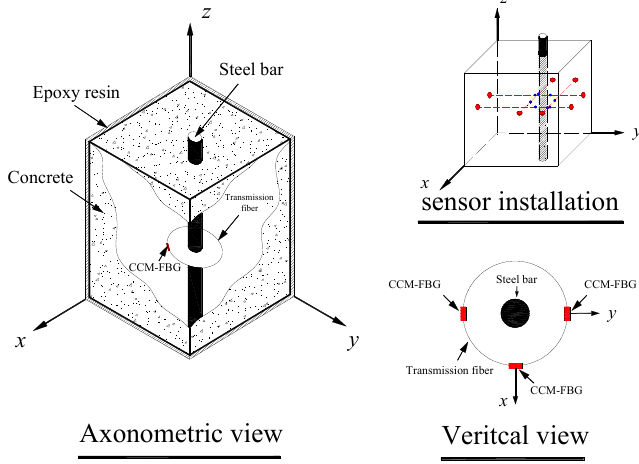
Figure 3. Design and embedding of CCM-FBG.